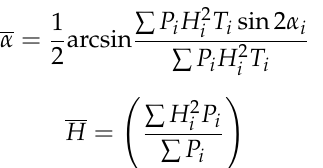
Table 1. Representative and simulated waves’ parameters.